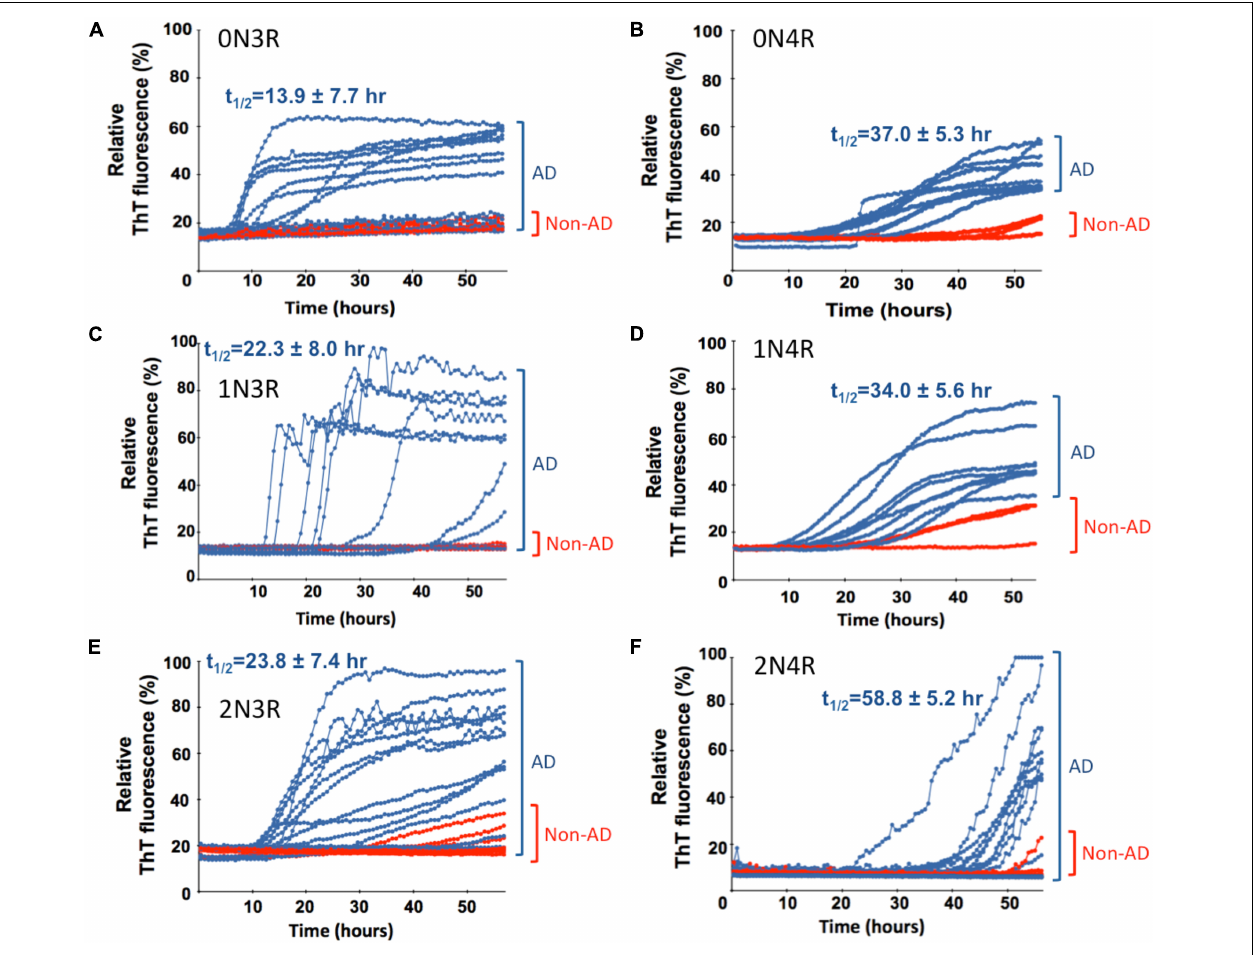
FIGURE 3 | Real-time quaking-induced conversion analyses (RT-QuIC) analysis of seeding activity of misfolded tau from autopsy brain tissues of post-mortem Alzheimer’s disease (AD) and non-AD cadavers in the presence of different recombinant tau isoform (labeled) as a substrate. Tau seeding activity of neuropathologically confirmed AD brains was examined by RT-QuIC assays in the presence of six different individual recombinant full-length tau isoforms. For all panels, seeding activities with AD brain homogenate are shown in blue traces and red traces for non-AD cases. Scattered plots, statistical evaluation of seeding activities, and numbers of cases for AD and non-AD control brains are shown in Figure 4 . Average t 1 / 2 values for the seeding traces of misfolded tau from AD brains with individual tau isoform substrate are indicated and related scattered plots and statistical evaluation are shown in Supplementary Figure 5